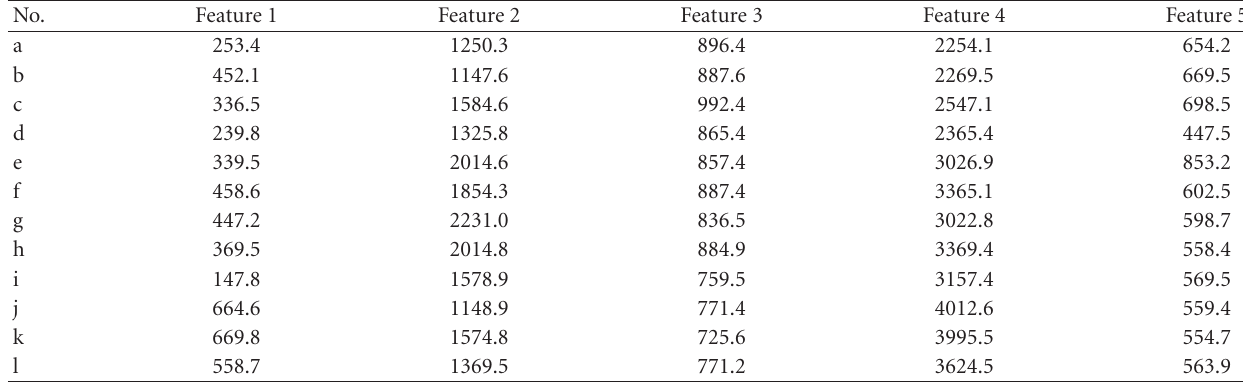
Table 3: Energy distribution surface mathematical features in NURBS surface.